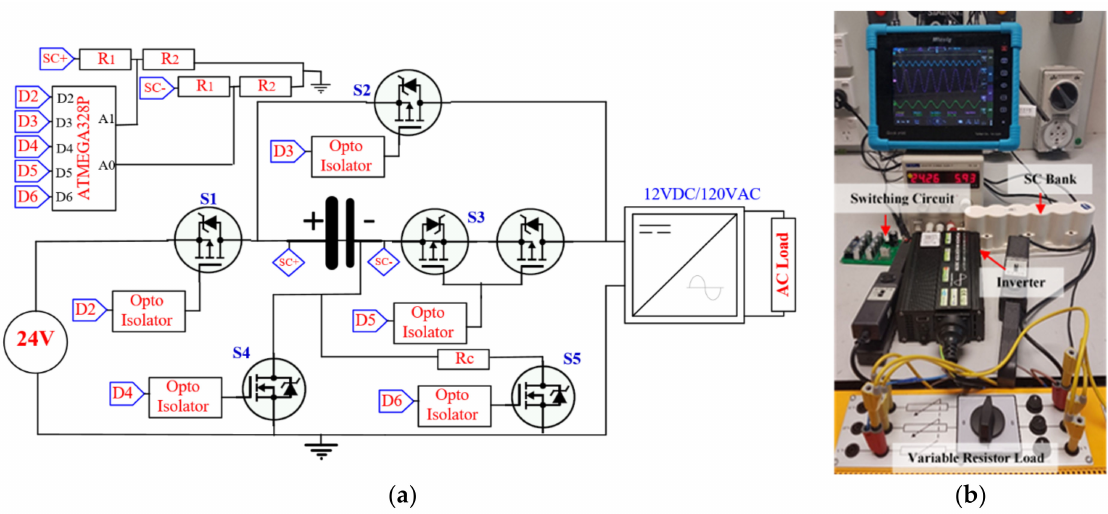
Figure 7. 24V-to-120V SCAWI-PV inverter prototype: ( a ) Informative schematic; ( b ) Test setup. IPP120P04P4L-03 P-channel MOSFETs (V DS = 40 V, R DS (on) = 3.1 m Ω , I D = 120 A) were used for the S1, S2 and S3 switches. For S4 and S5, IRF740 N-channel MOSFETs (V DS = 400 V, R DS (on) = 0.55 Ω , I D = 10 A) were used. Switches S1 and S3 control